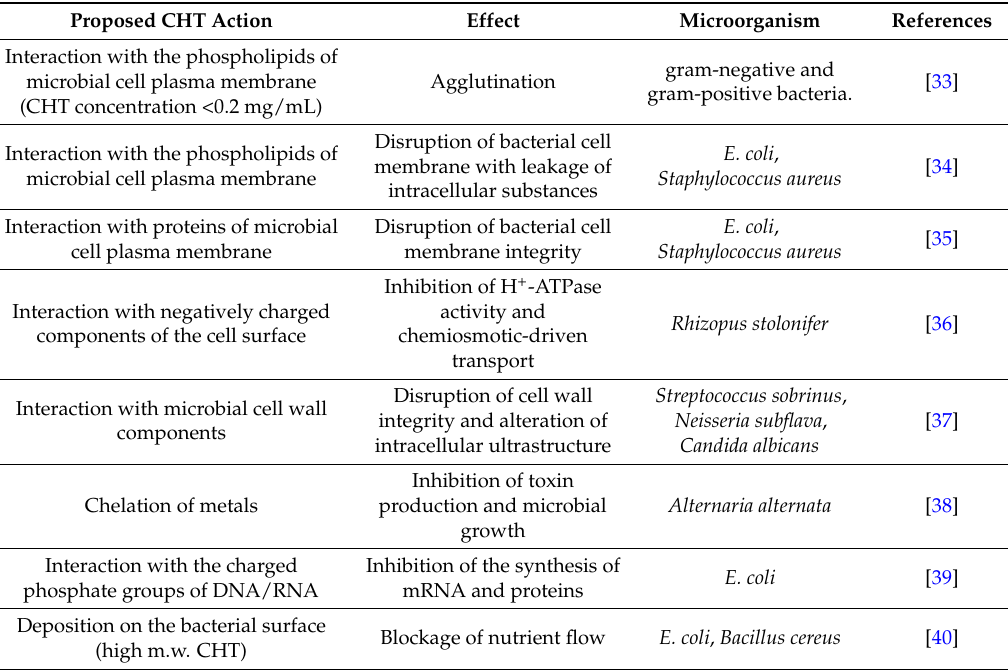
Table 1. Proposed mechanisms for the antimicrobial effect of